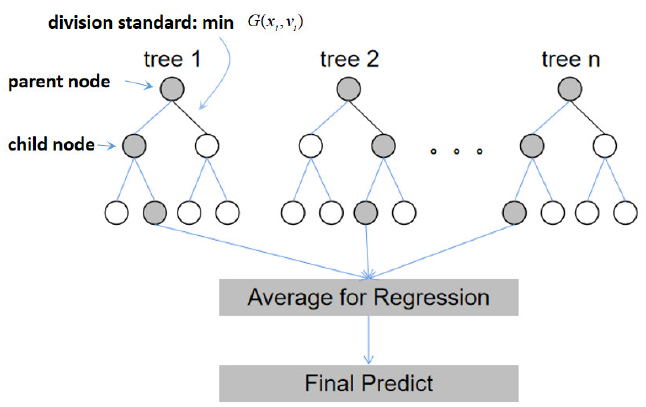
Figure 3. The random forest algorithm.